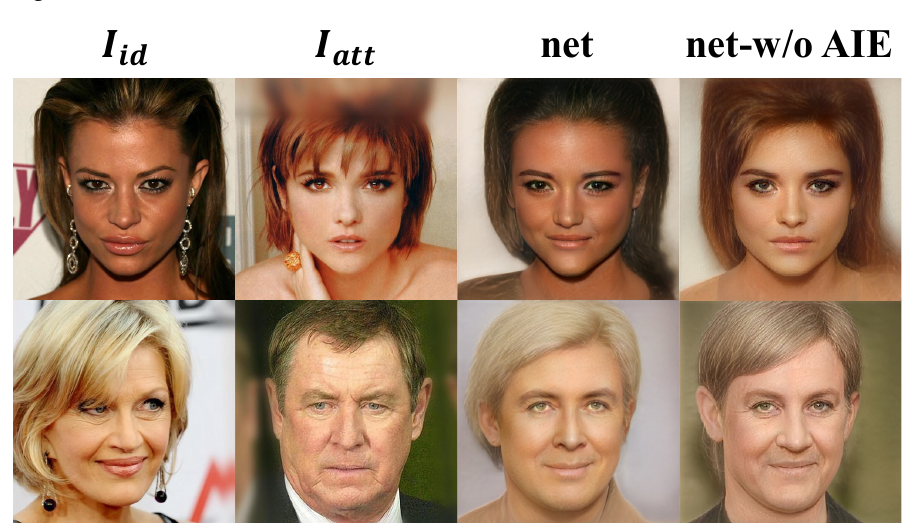
Figure 6. The results of the experiment to verify the superiority of the adaptive editing